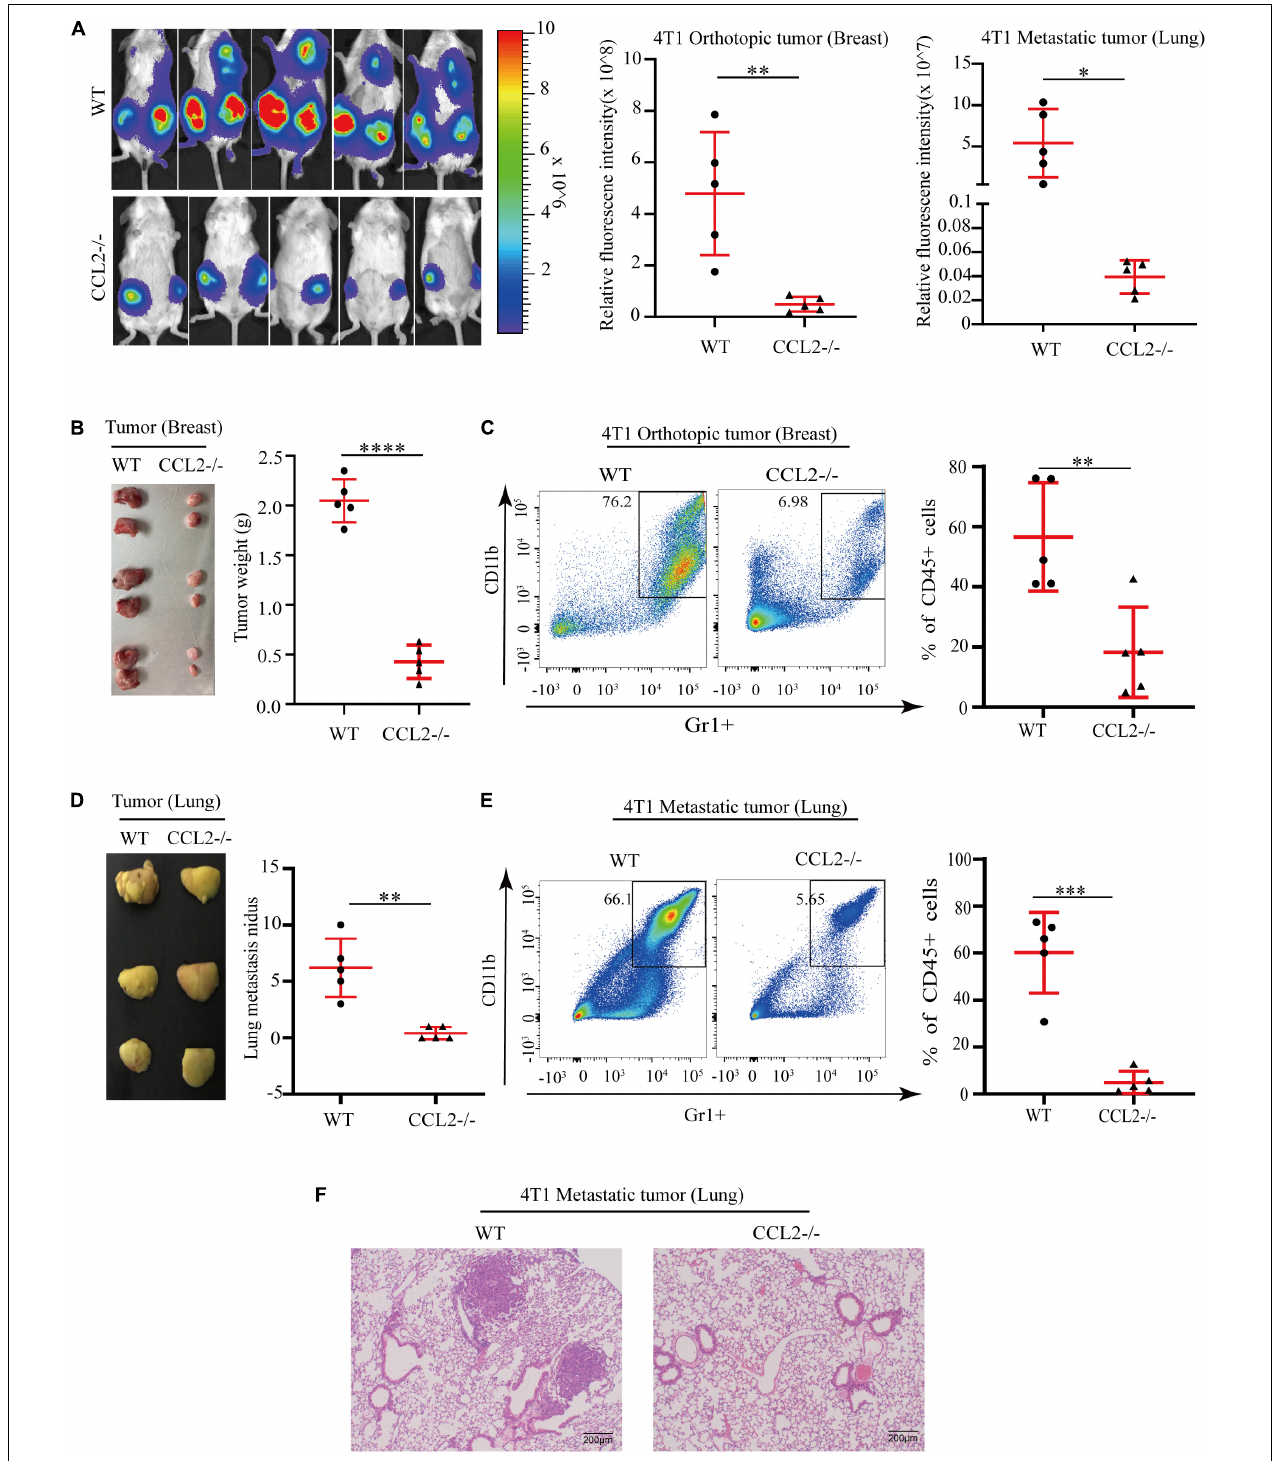
FIGURE 1 | CCL2 promotes the growth and metastasis of breast cancer by recruiting MDSCs. (A) Measurement (left) and fluorescence intensity (right) of 4T1 orthotopic growth and lung metastasis in both WT and CCL2/in an in vivo imaging system ( n = 5). (B) Representative photographs of orthotopic breast tumor (left) and tumor weight (right) in the mammary gland of WT and CCL2–/– mice after 42 days of 4T1 BC cells transplanted into the mammary fat pad. (C) Analysis of tumor infiltration MDSCs in both WT and CCL2–/– mice by FACS ( n = 5). (D) Representative photographs of lung metastasis tumor (left) and lung metastasis nidus counts (right) in both WT and CCL2–/– tumor-bearing mice was counted after fix stained with Bouin’s solution. (E) Analysis of MDSCs recruitment in the lung of both WT and CCL2–/– tumor-bearing mice by FACS ( n = 5). (F) Representative hematoxylin-eosin staining of lung metastasis tumor. Bar = 200 µ m (magnification: 100 × ). P values were calculated by unpaired Student’s t -test (* P < 0.05, ** P < 0.01, *** P < 0.001, **** P < 0.0001).